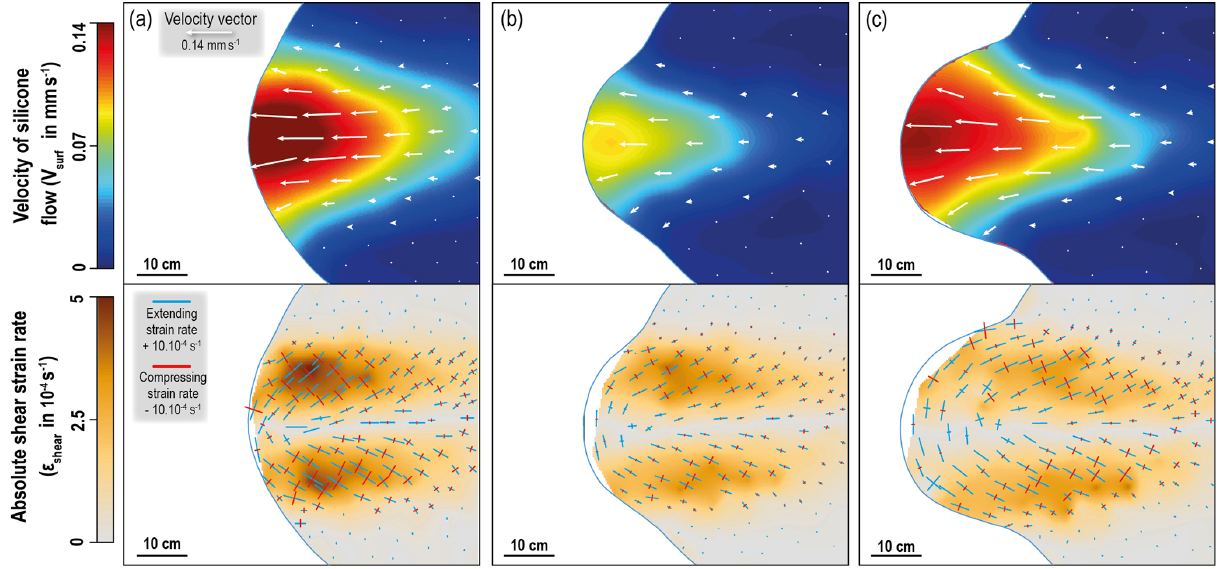
Figure 9. Temporal evolution (same stages a, b and c as in Fig. 8) of the surface behaviour of the silicone stream and lobe system, for a typical experiment with poorly developed channelized drainage (Experiment 14). Same panels as in Fig.